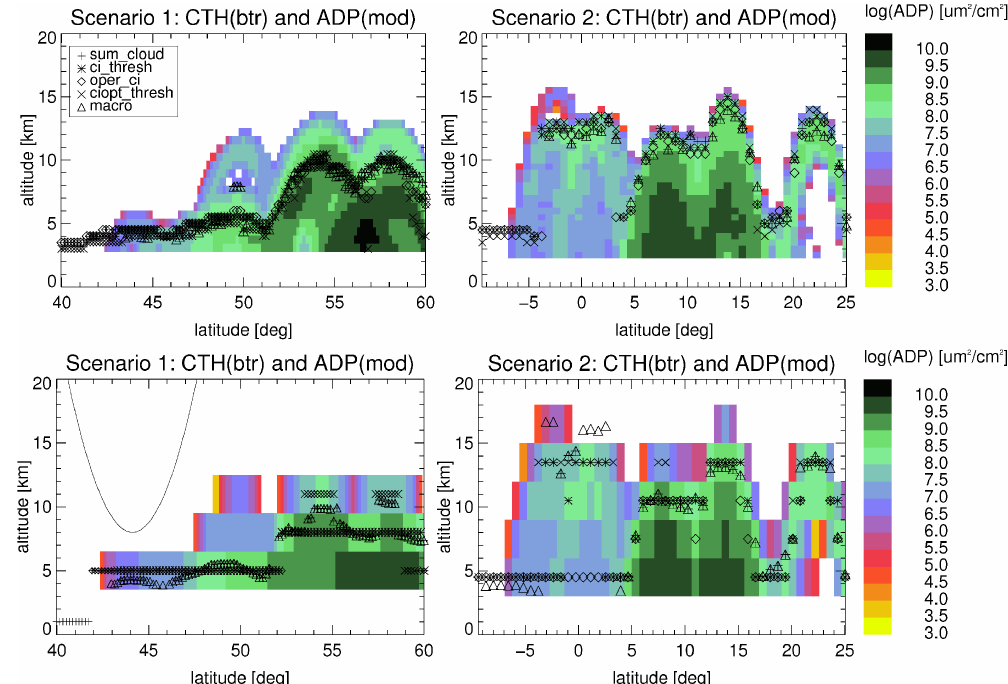
Fig. 8. Colour-coded area density path (ADP mod ) of the so-called “true state” of the cloudy atmosphere presented for latitude versus altitude, computed from the corresponding IWC distribution of Fig. 7 and effective radius information along the line of sight. No field of view is applied for the top panels and a MIPAS field of view of 3km is convolved for the lower panels. Blind test retrieval (btr) results of CTH for various detection methods of the processor are overlaid (black symbols). CTHs at 1km altitude indicate non-cloudy conditions based on the retrieval. Each colour-coded ADP box represents the integrated ADP along a limb path with a corresponding tangent height in the centre of the box. Superimposed in Scenario 1 with MIPAS FOV is a typical limb path for a tangent height of